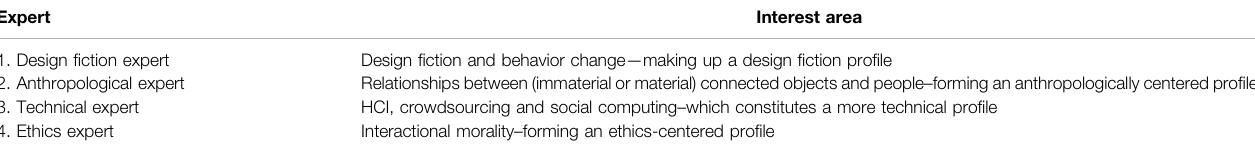
TABLE 2 | The interviewed researchers and their areas of expertise.